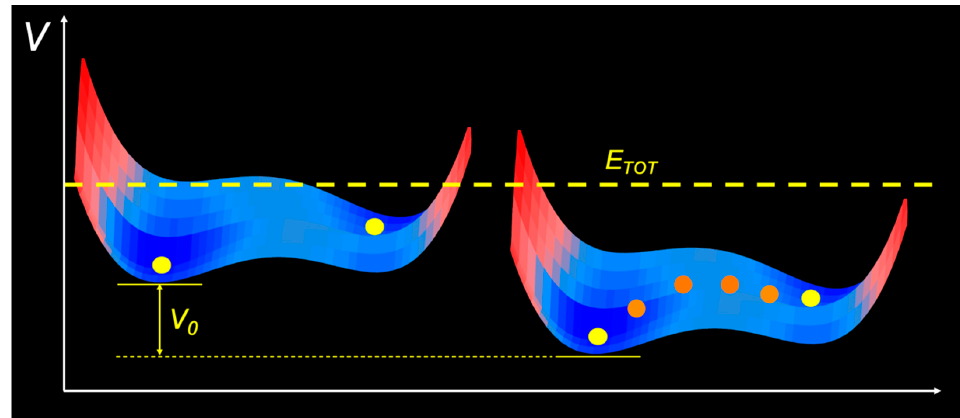
Figure 8. Downshifting of the double well potential, which, starting from the resonance condition, keeping constant the total energy, corresponds to an increase of the system kinetic energy and hence of temperature.